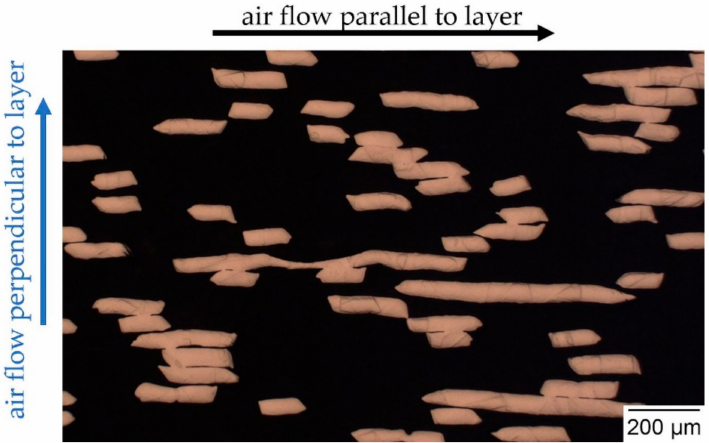
Figure 13. Micrograph of an expanded sheet metal structure cross section with 77% porosity. Arrows indicate flow directions (arrow colors correspond to arrows in Figure